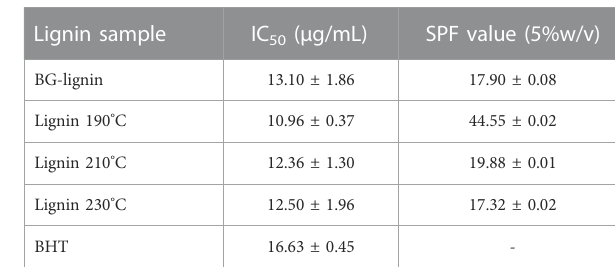
TABLE 2 Antioxidation property and SPF organosolv lignin extracted from bagasse before and after thermal modi fi cation.